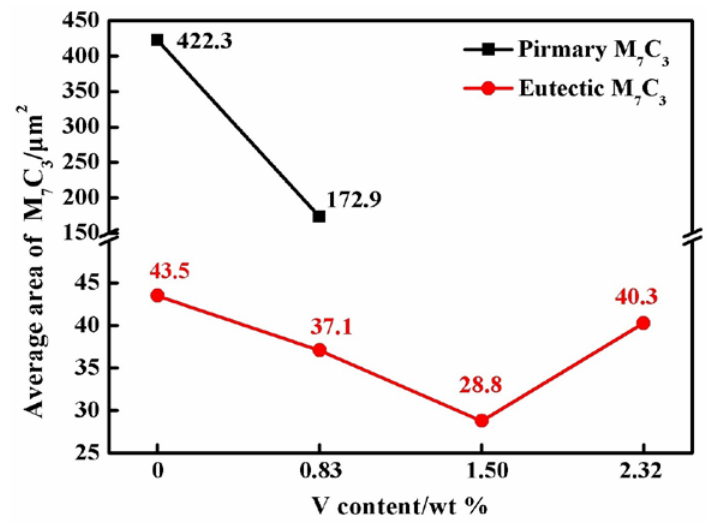
Figure 13. Average area of M 7 C 3 carbides in different HCCI hardfacing layers.